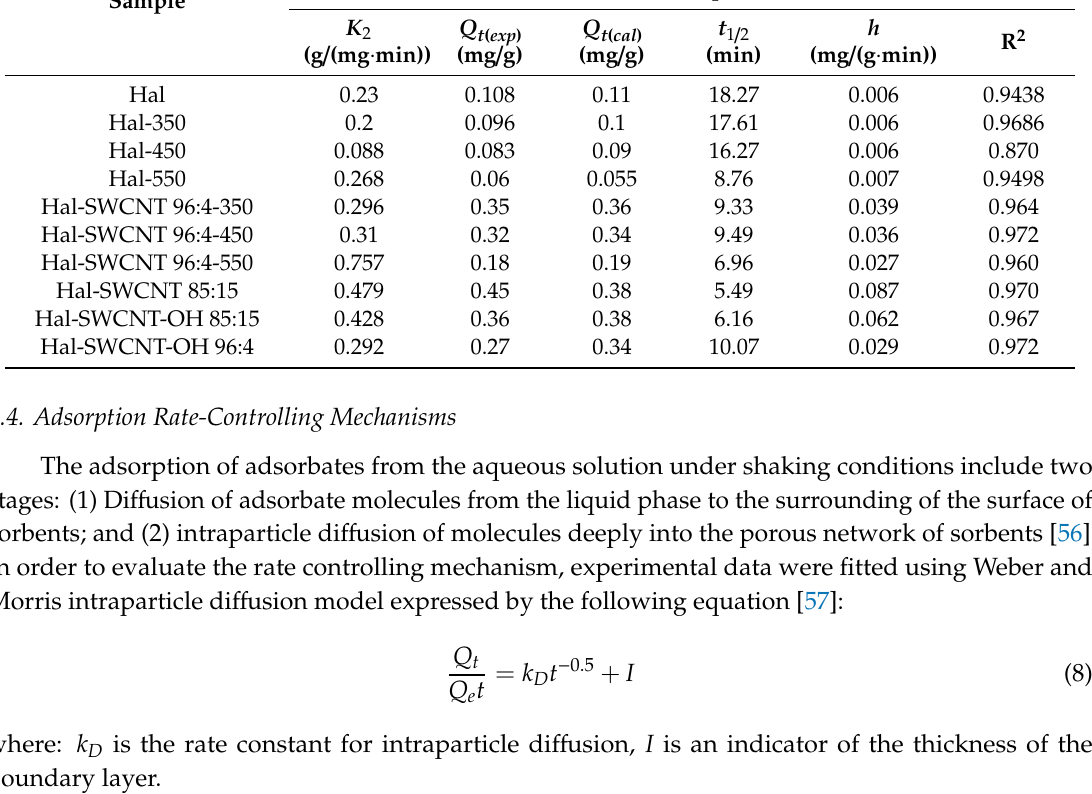
Table 6. The parameters of the pseudo-second-order kinetic equation for the adsorption of ANT on Hal, Hal-350, Hal-450, Hal-550 and Hal-CNT composites.